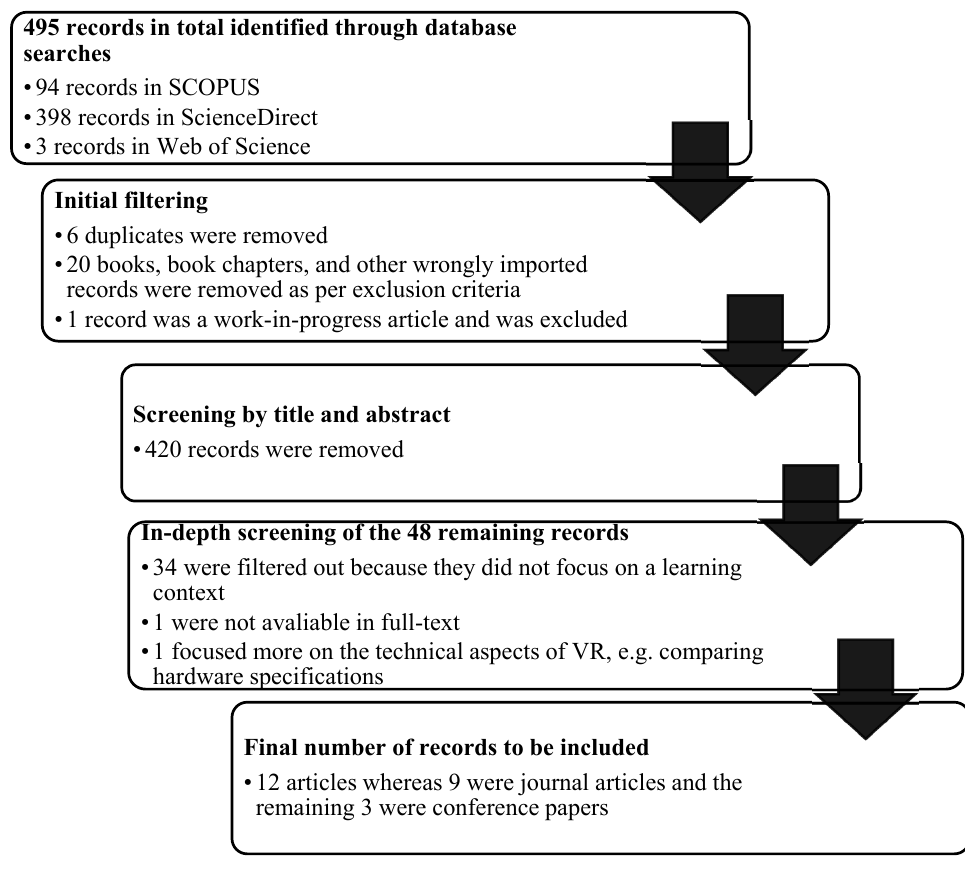
Figure 1. The various stages in the screening process.